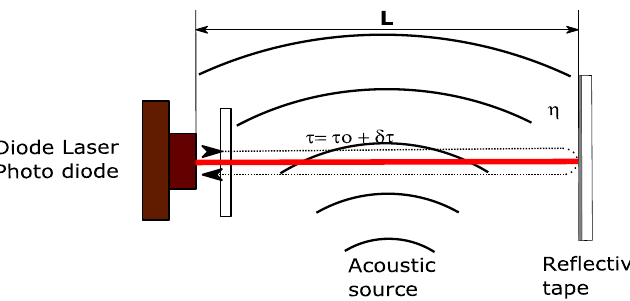
Figure 1. Principle of acoustic pressure sensing using optical feedback interferometry. The distance between the laser and the mirror is fixed; the laser diode and the monitoring photodiode are in the same package.